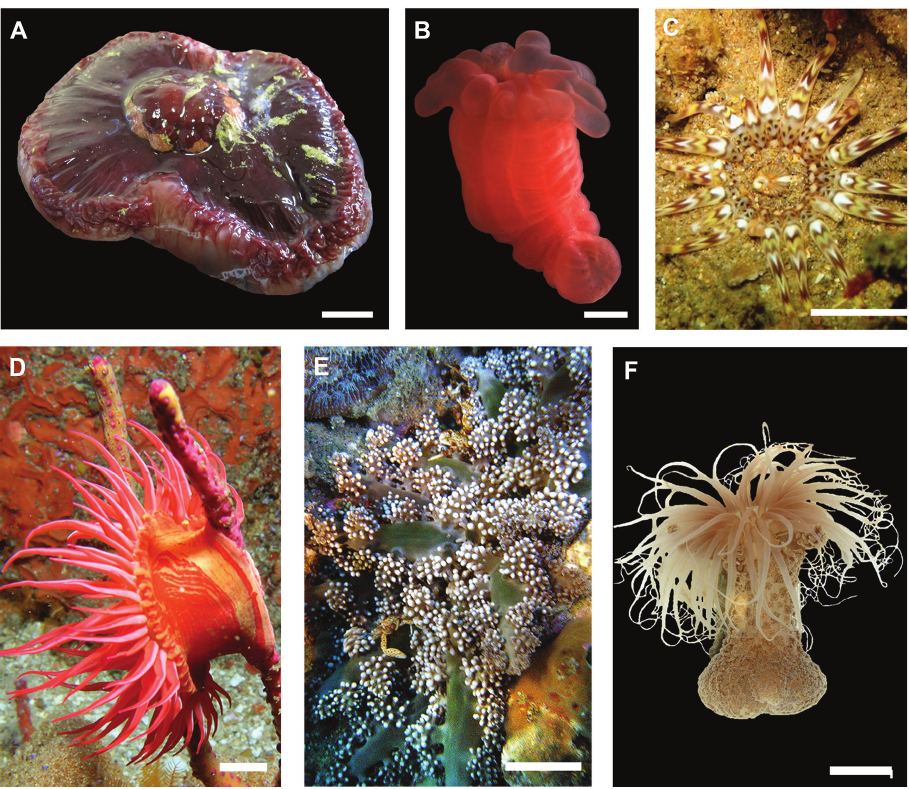
Figure 4. Six of the twelve species recorded from South Africa for the first time: A Actinoscyphia plebeia (20mm) B Peachia paracitica (2mm) C Peachia sp. (20mm) D Pseudactinia sp. (10 mm) E Megalactis grif- fithsi (10 mm) and F Alicia sansibarensis (20mm). Photographs taken by Dr Lara Atkinson ( A ), Dr Megan Laird ( B, E ), Andre Aggenbach ( C ), Dr Bernard Picton ( D ) and Dr Kerry Sink ( F ).